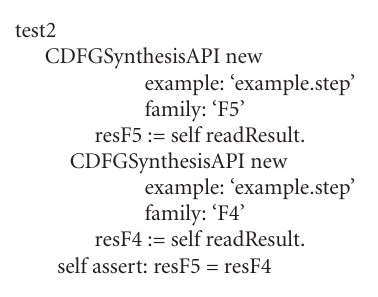
Algorithm 2: Characterization-based validation for synthesis cases on two reconfigurable device families (F5 and F4). Both postsimulation memories contents are checked to be